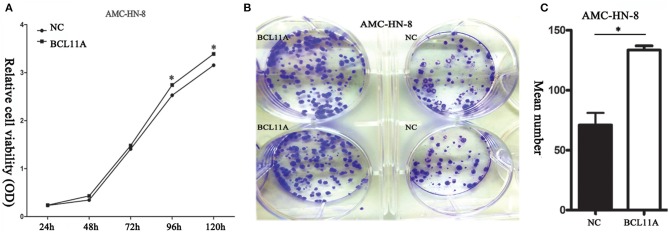
(A) BCL11A overexpression increased AMC-HN-8 cell proliferation. (B) Overexpression of BCL11A in the AMC-HN-8 cells significantly increased their colony-forming abilities. (C) Quantitative comparison of the colonies formed from the parental AMC-HN-8 cells (NC) and the BCL11A overexpression (BCL11A) ones. *P < 0.05.